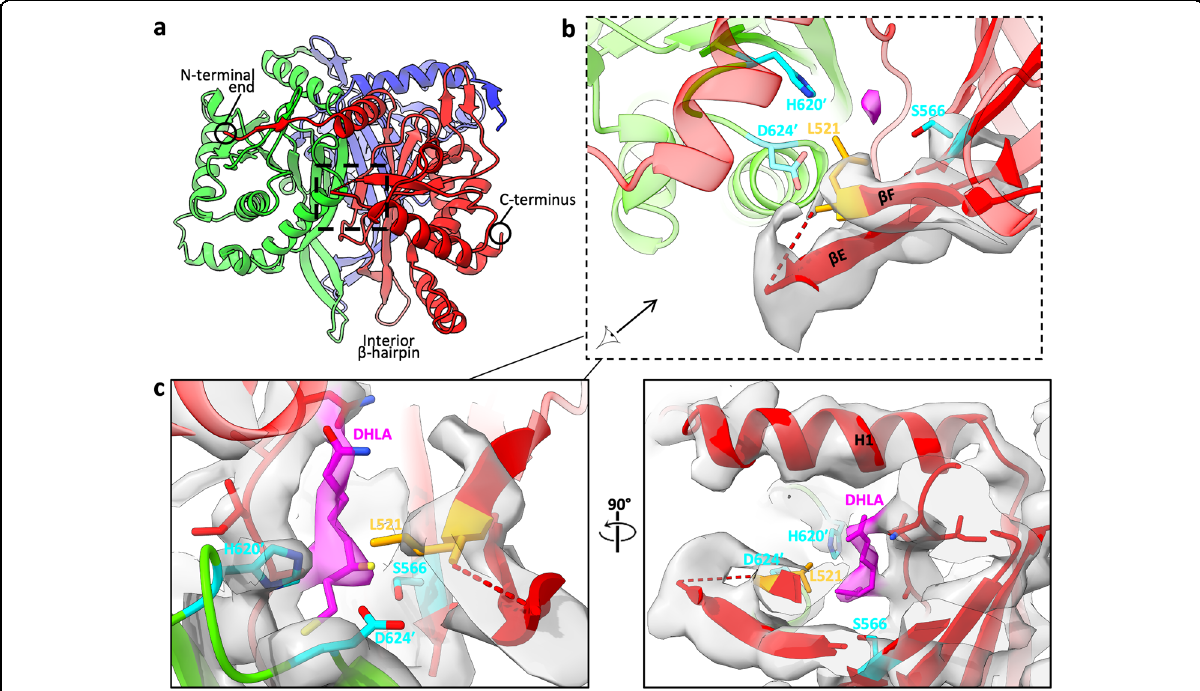
Fig. 5 The interdomain active site within the bovine PDC E2 IC domain trimers. a Ribbon-model of E2p trimer (colored by subunits) with boxes highlighting the relative locations of the fl exible β E – β F turn (black box). b Enlarged views of the β E – β F turn near interdomain active site relative to conserved catalytic residues (teal), Ser566 from the red subunit and His620 and Asp624 from the green subunit. Two residues (Ala519 and Gly520) are unmodeled in the turn due to absence of continuous cryo-EM density (semi-transparent gray; for clarity, only those for β E – turn – β F are shown), suggesting fl exibility of the residues in the turn. The conserved leucine gatekeeper (orange) is next to these unmodeled residues. A weak density (pink) bordered by catalytic and gatekeeper residues within active site is visible. c Cryo-EM density of the same region of b shown at a decreased threshold as semi-transparent pink for the lipoyl moiety or gray for the surrounding region. Atomic models for the lipoyl moiety (from PDB ID: 1EAE) and the surrounding area are shown as sticks and ribbon,